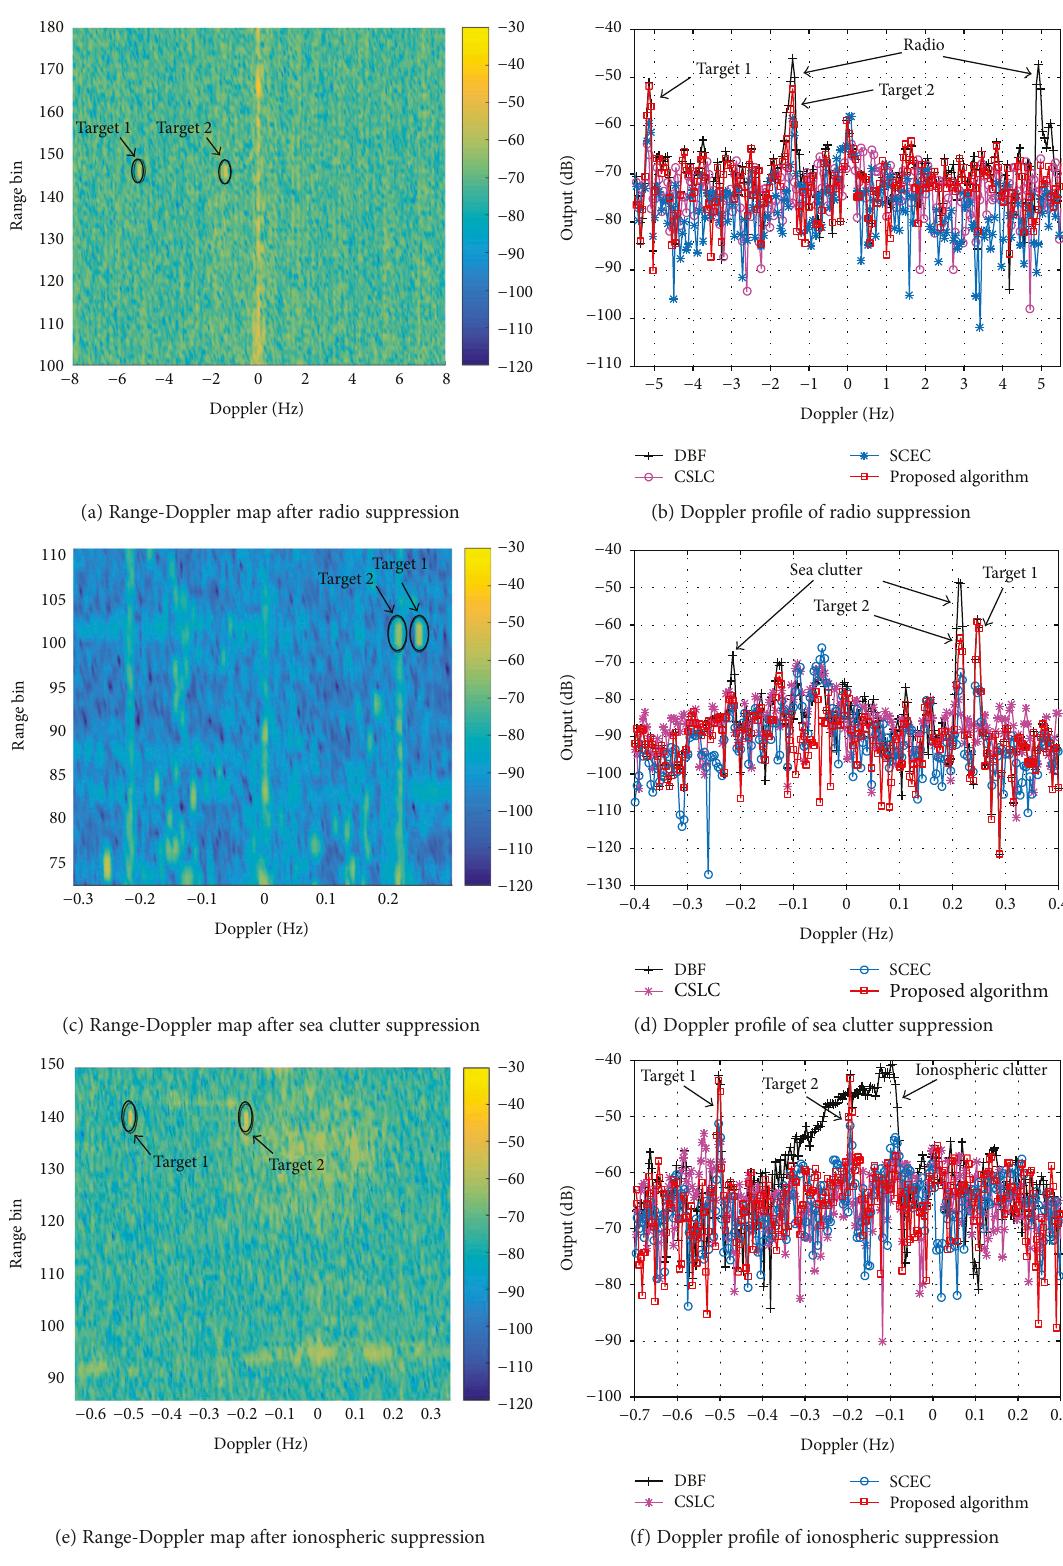
Figure 12: Comparison results for radio and clutter cancellation with the simulated real